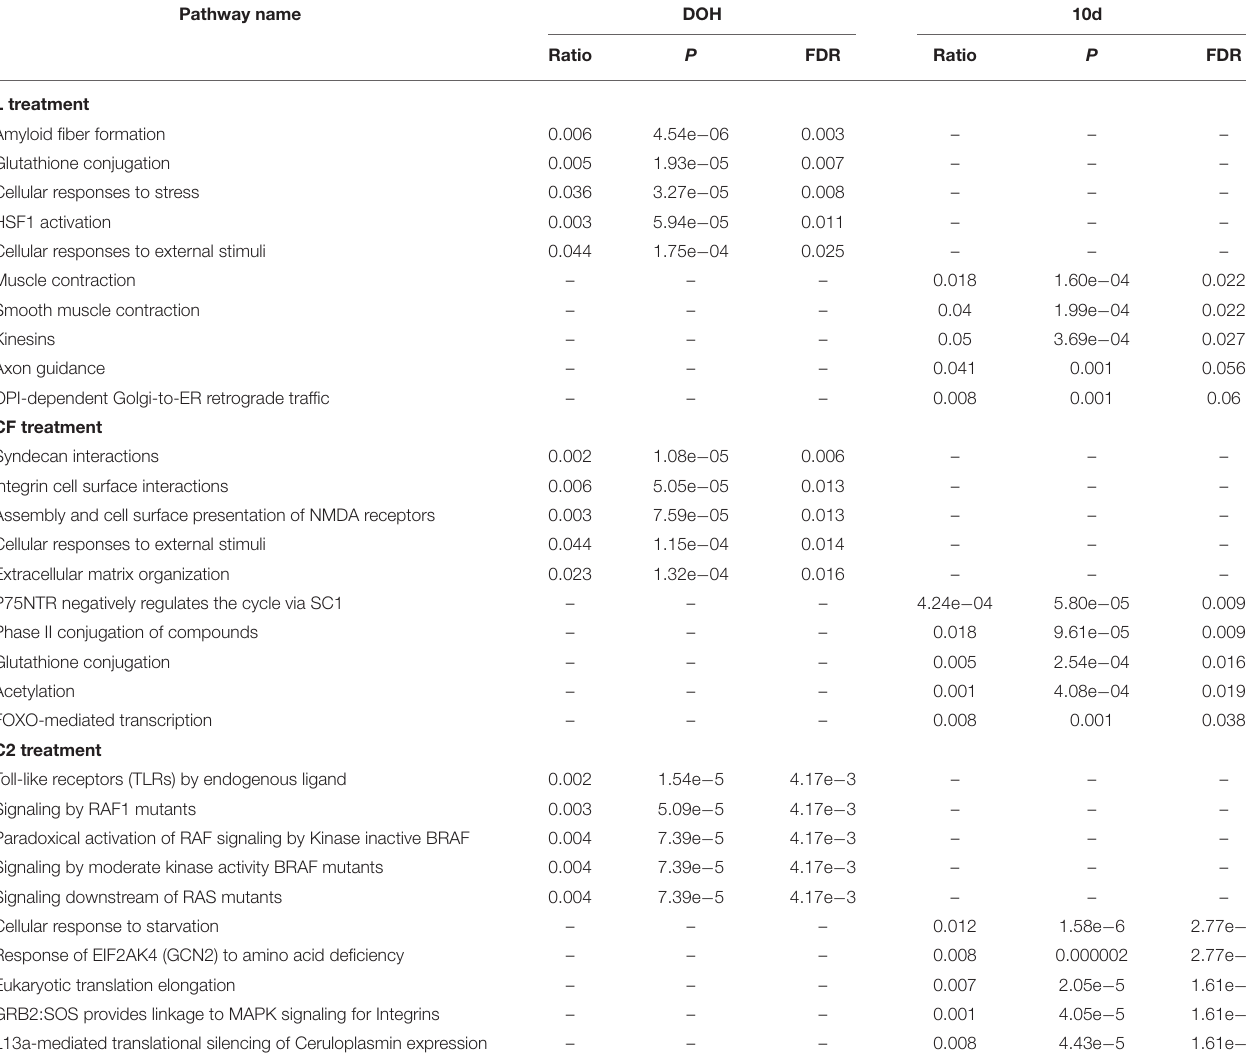
TABLE 1 | The five most significant pathways based on the upregulated proteins expressed in intestinal samples of broilers treated with lactic acid bacteria (L), Citrobacter freundii (CF) or Citrobacter spp. (C2) in relation to control treatment at the day of the hatch (DOH) and 10 days of age